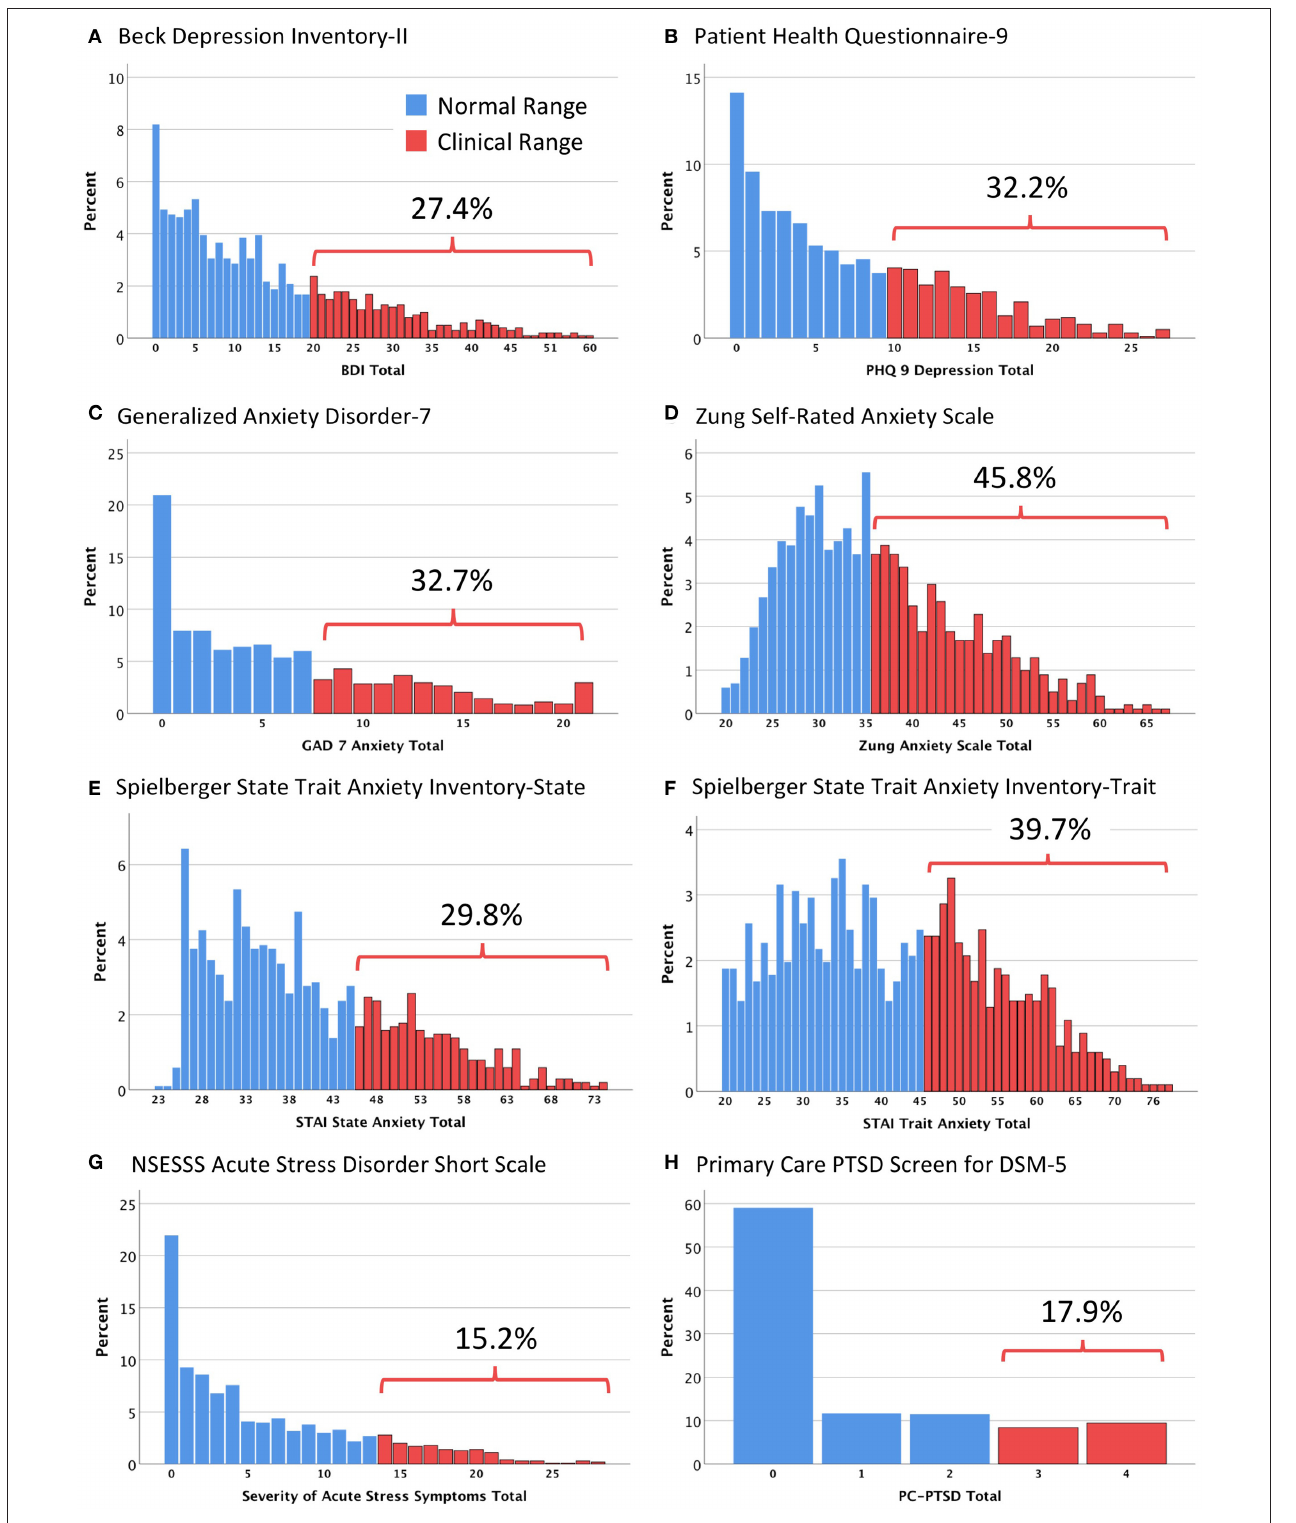
FIGURE 1 | Histograms showing the distribution of scores on the eight major mental health assessment questionnaires. (A) Beck Depression Inventory-II (BDI); (B) Patient Health Questionnaire-9 (PHQ 9); (C) Generalized Anxiety Disorder-7 (GAD 7); (D) Zung Self-Rated Anxiety Scale; (E) Spielberger State Trait Anxiety Inventory-State (STAI State); (F) Spielberger State Trait Anxiety Inventory-Trait (STAI Trait); (G) NSESSS Acute Stress Disorder Short Scale; (H) Primary Care PTSD Screen for DSM-5 (PC-PTSD). Bars represent the percentage of participants obtaining a particular score. Each histogram divides the sample into those who met published cut-off points for clinical significance (blue, normal range; red, clinical range).